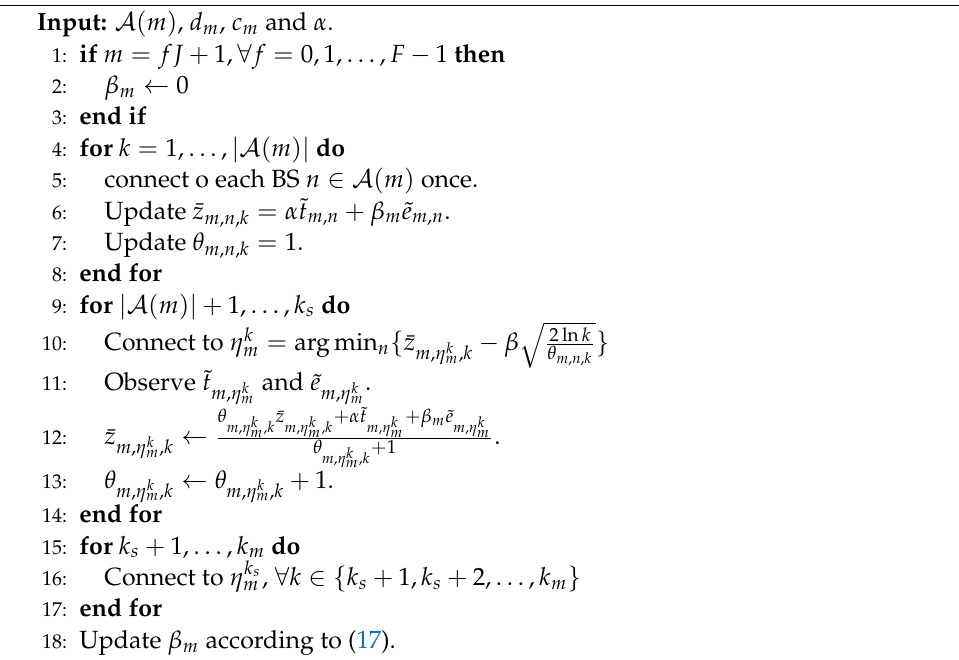
Algorithm 2: Mobility-aware online BS learning